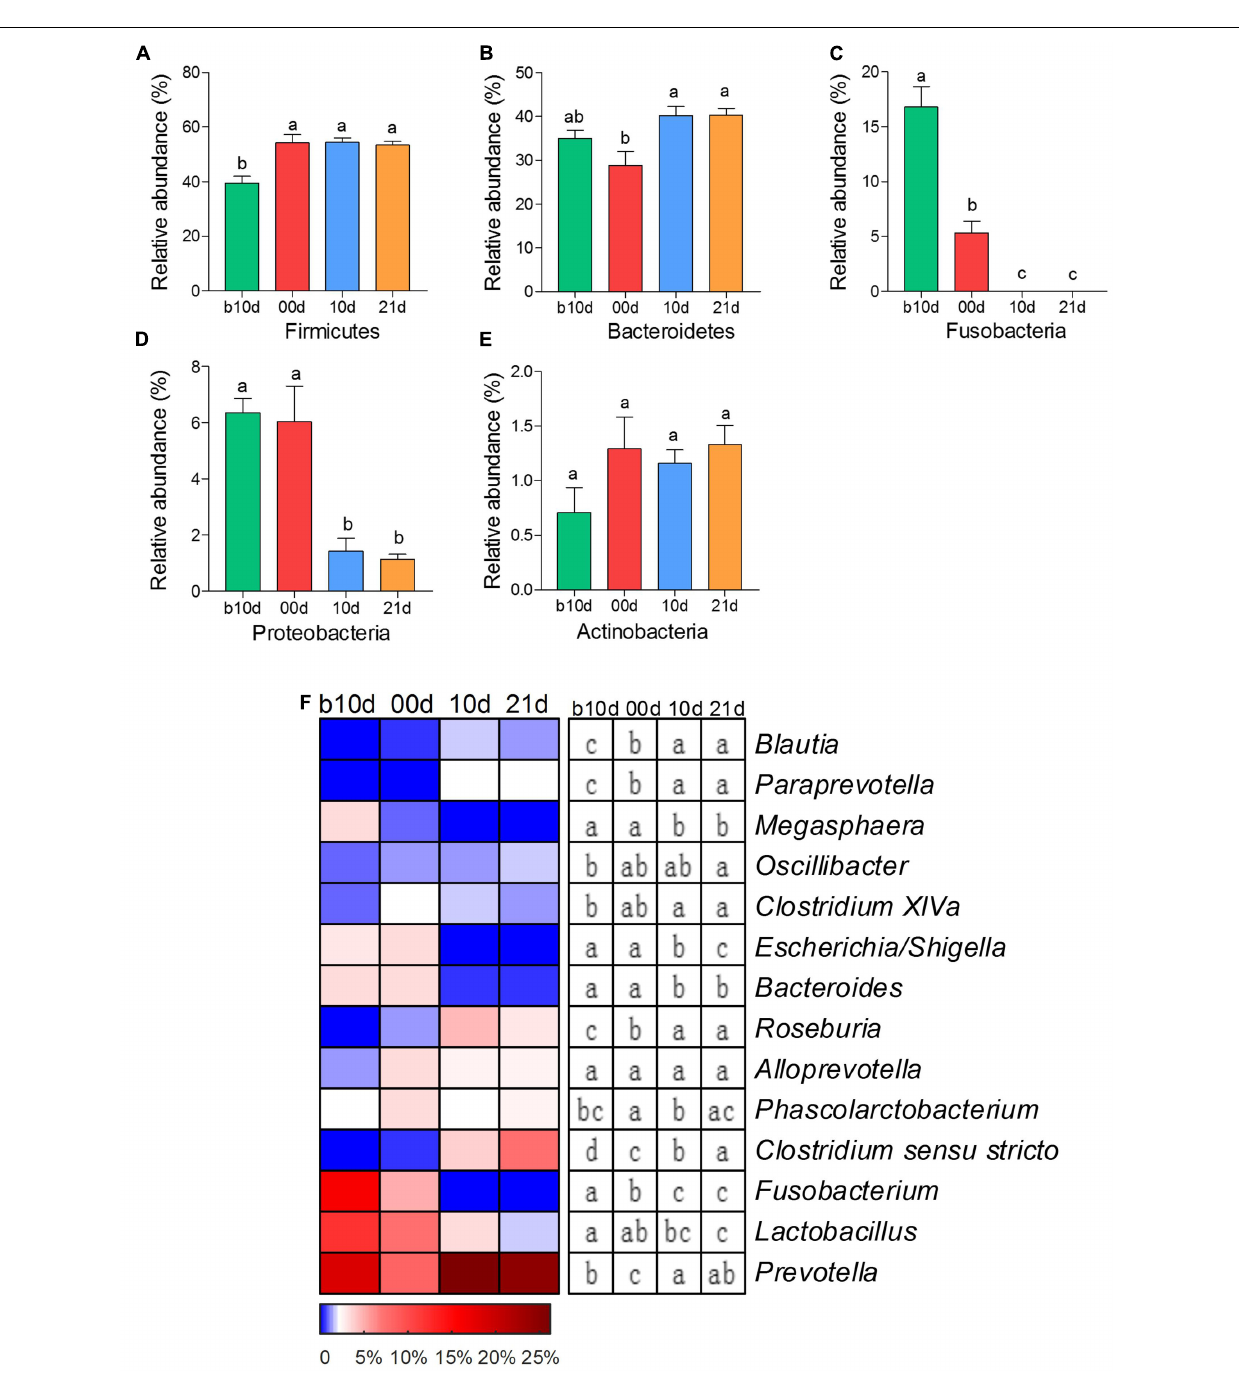
Figure 3). PERMANOVA based on Bray–Curtis and